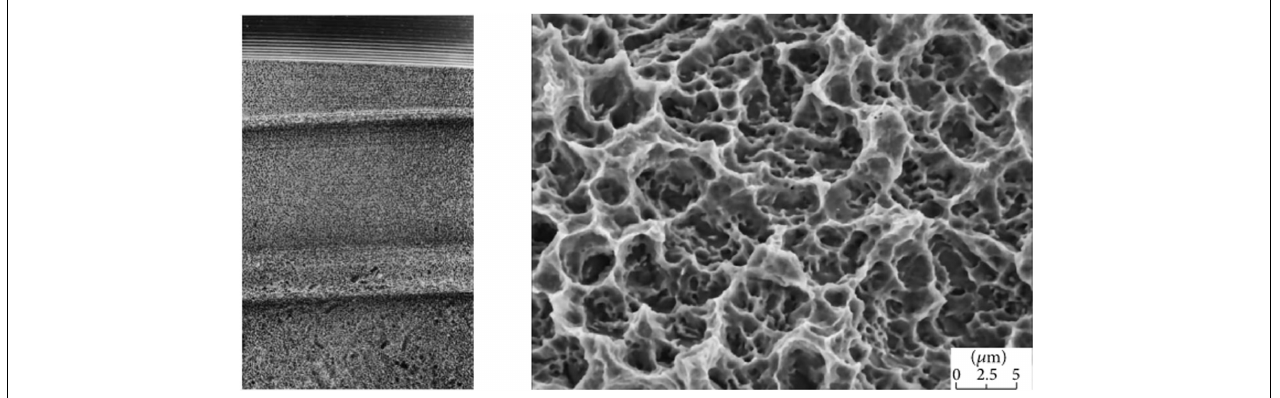
FIGURE 2 | Surface features and scanning electron micrographs of a FRIADENT plus surface.